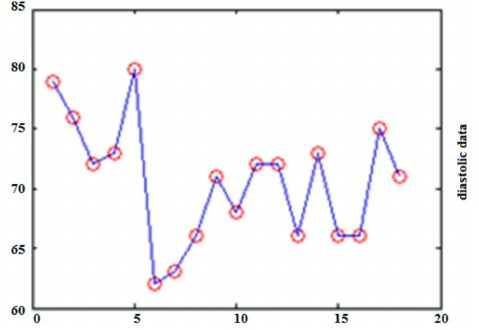
Figure 23. The learning of the neural network with the diastolic data provided.